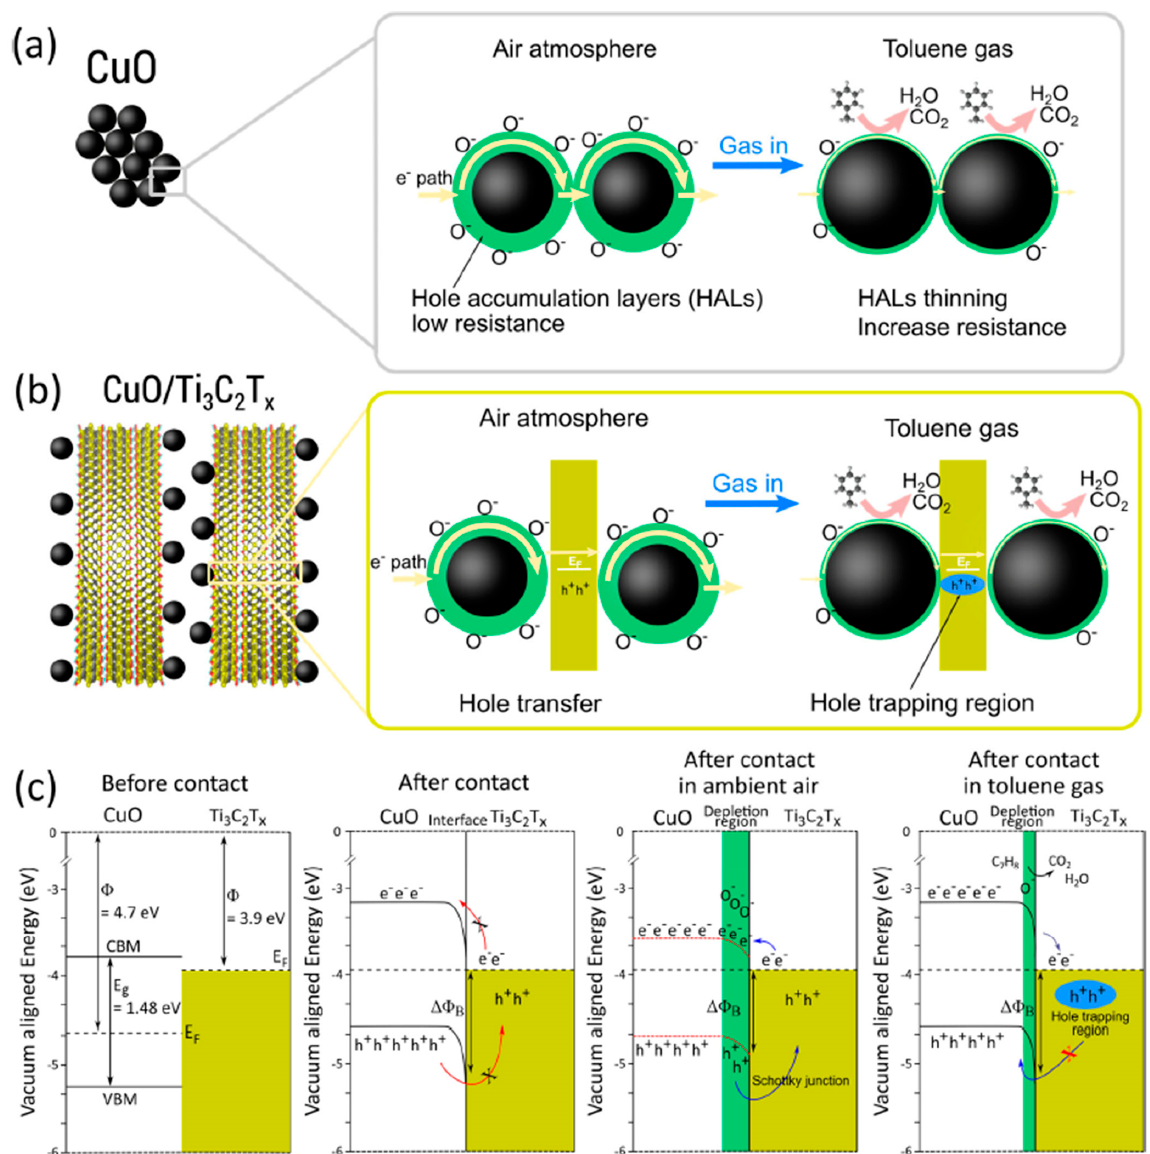
Figure 30. Gas-sensing mechanism of ( a ) pristine CuO nanoparticles and ( b ) CuO nanoparti- cles/Ti 3 C 2 T x MXene hybrid heterostructures. ( c ) Band structure alignment of CuO/Ti 3 C 2 T x before contact, after contact, in ambient air, and in toluene gas. Reprinted with permission from [141]. Copyright 2020: American Chemical Society.